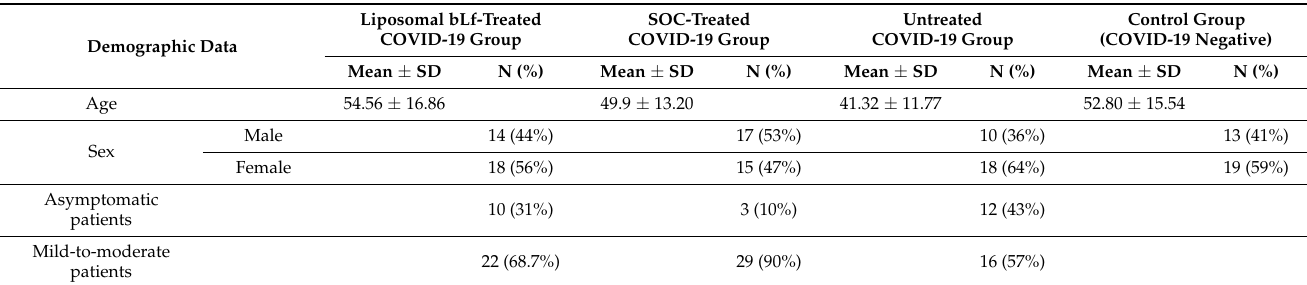
Figure 2. A total of 92 patients with confirmed COVID-19 infection at reverse transcriptase real time (rRT)-PCR were recruited to participate in this study. Patients were divided into three groups according to the administered treatment. Thirty-two patients were treated with liposomal bovine lactoferrin (bLf); another 32 patients received a standard of care (SOC) regimen; while 28 patients did not receive any treatment against COVID-19. As a control group, 32 healthy volunteers with negative COVID-19 infection at rRT-PCR naso-oropharyngeal swab were recruited. Demographic data of the groups are summarized in Table 1. Table 1. Demographic data of the patients enrolled in the preliminary clinical trial. BLf = bovine lactoferrin; SOC = standard of care; SD = standard